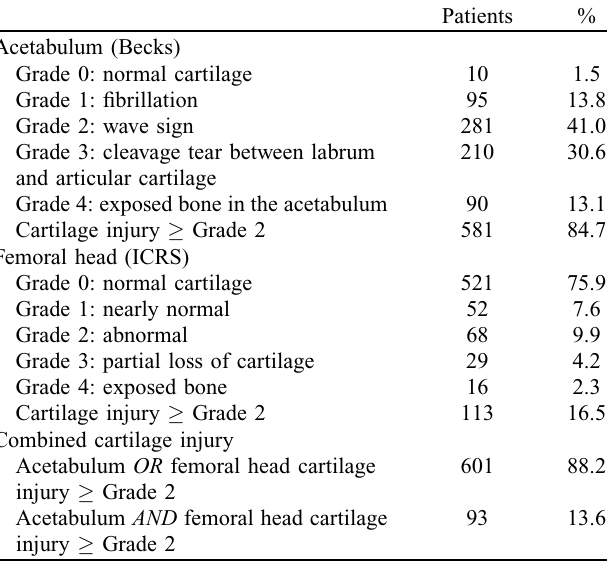
Table 1. Degree of injury for acetabulum and femoral head. Table 2. Cartilage procedures in patients undergoing arthroscopic FAI